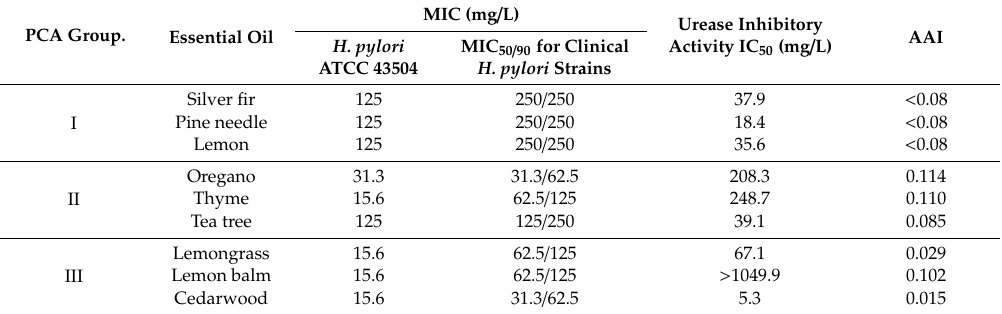
Table 5. Biological activity of essential oils in relation to principal component analysis (PCA) groups. PCA